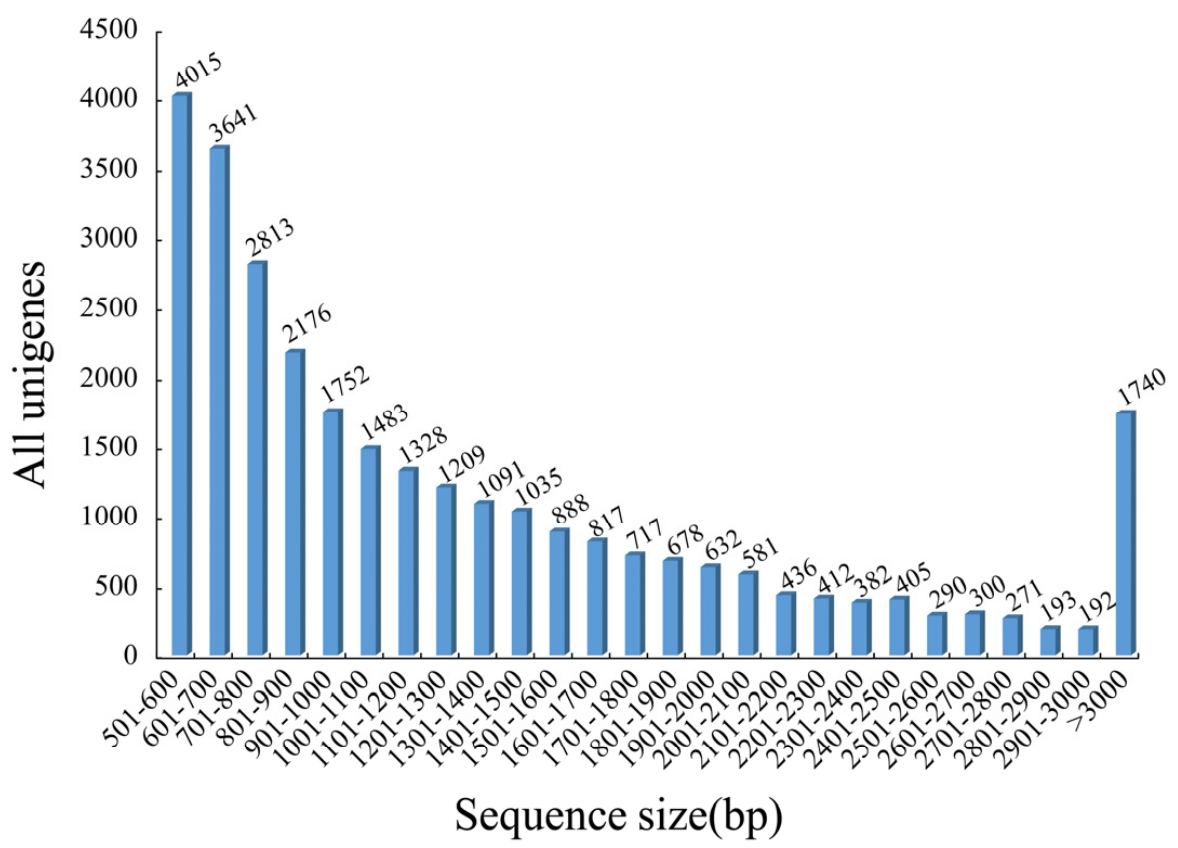
Figure 1. Distribution of unigene lengths of C. macrophyllum .